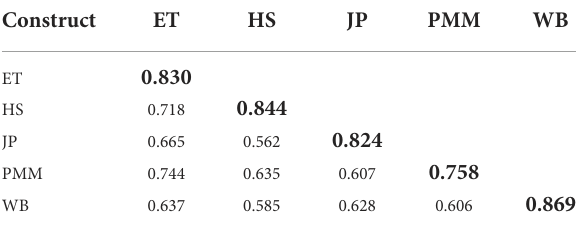
TABLE 2 Discriminant validity (Fornell-Larker-1981 criteria).